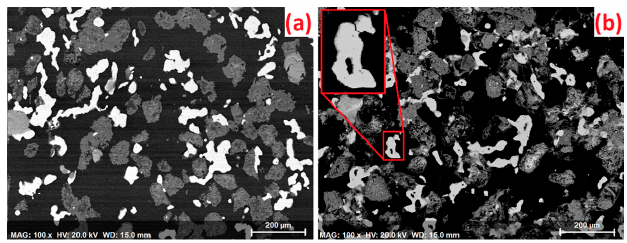
Figure 6. Backscattered electron micrographs of the products from reduction with ( a ) 19 wt % graphite and ( b ) 22 wt % graphite.